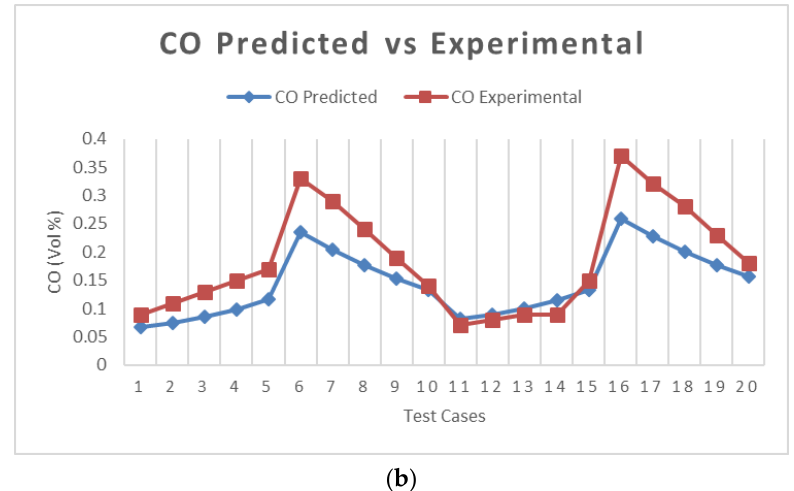
Figure 8. ( a ) Depiction of predicted and experimentally obtained CO values taken for 20 test cases; ( b ) Regression coefficient for the values predicted using ANN Vs experimental.